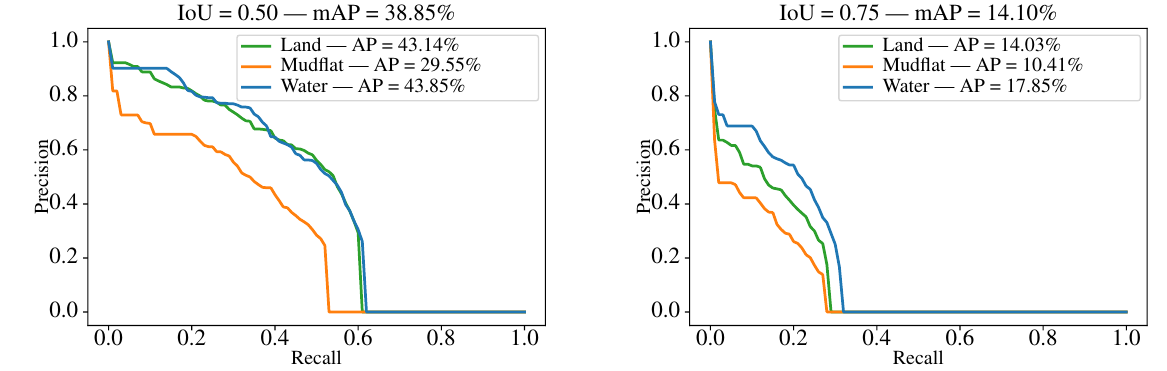
Figure 6. Precision-Recall curves for RetinaNet and two IoU thresholds.